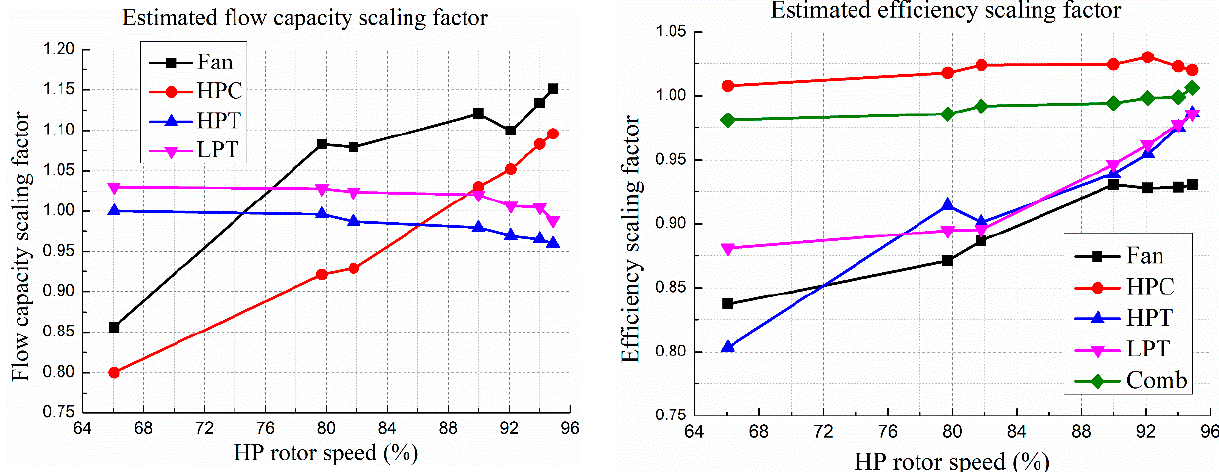
Figure 9. Estimated characteristic scaling factor. After the implementation of the model update with estimated scaling factors, Table 5 presents the simulated errors compared with experimental data before and after the